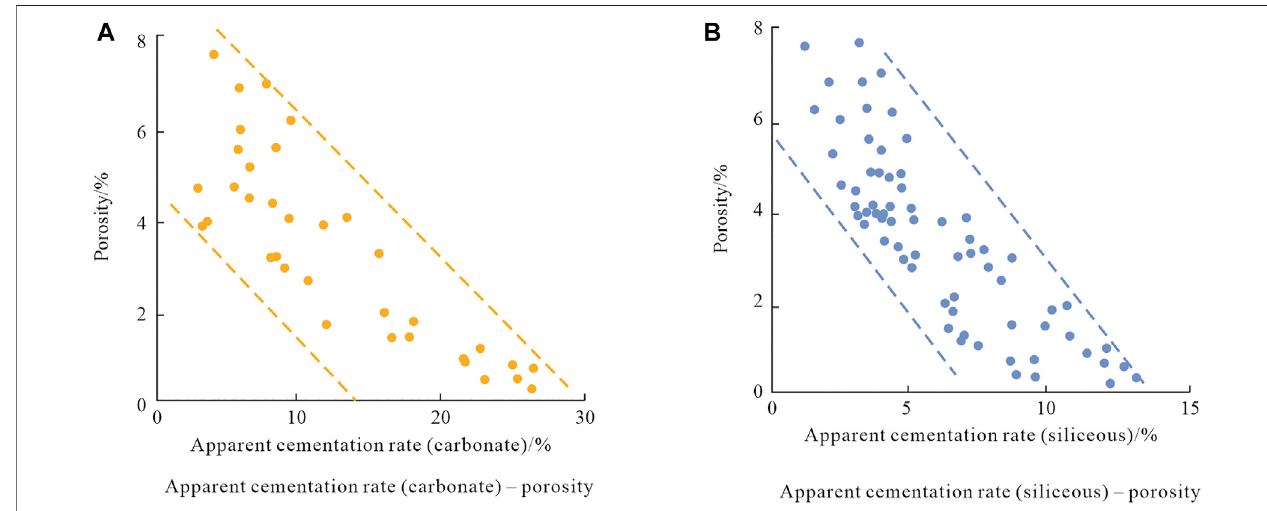
FIGURE 16 | Relationship between diagenesis parameters and reservoir porosity of the Xiaoheba Formation in the southern area; (A) Apparent cementation rate (carbonate) — porosity; (B) Apparent cementation rate (siliceous) — porosity